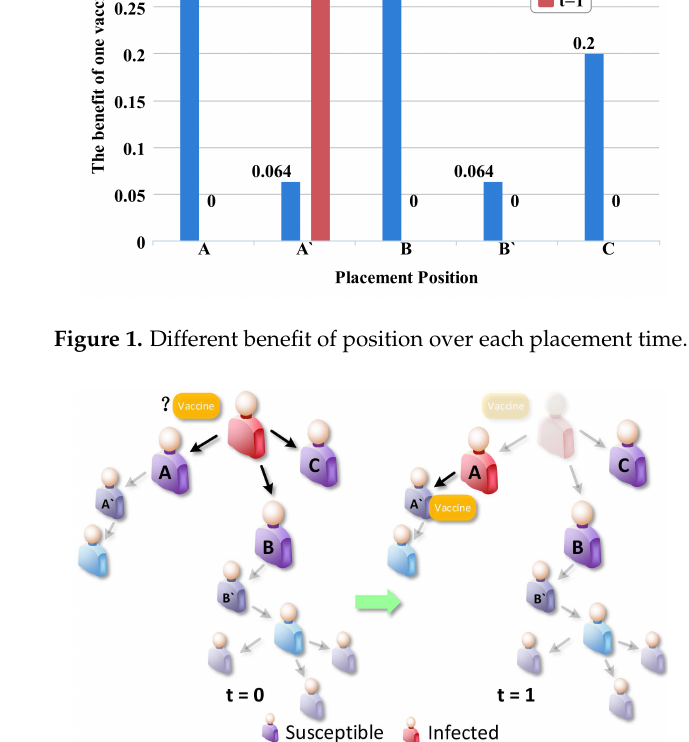
Figure 2. Intuition underlying DWPV use of time division in distributing vaccines: The figure shows an infected node (in red) and some susceptible nodes (in blue). The infected node has one chance to infect their neighbors at t = 0. At t = 1, the node A has been infected by the initially infected node and other nodes (B and C) are lucky